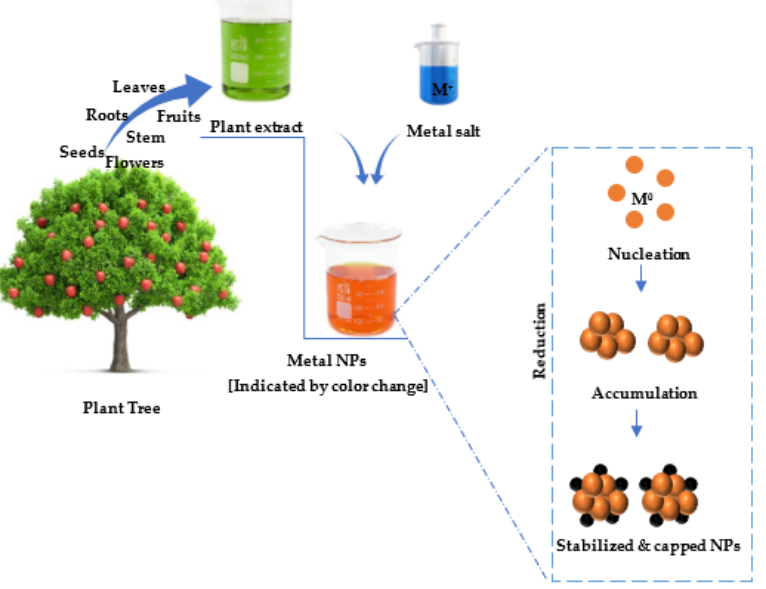
Figure 1. Synthesis of metal NPs using plant extracts.